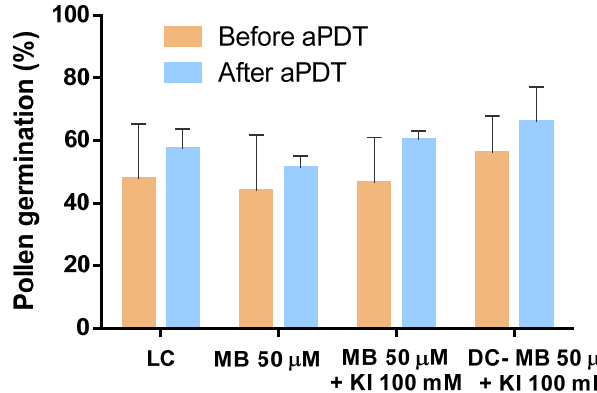
Figure 11. Evaluation of pollen germination before and after aPDT. Values represent the mean of pollen germination percentage resulting from three independent assays in triplicate; error bars represent the standard deviation.